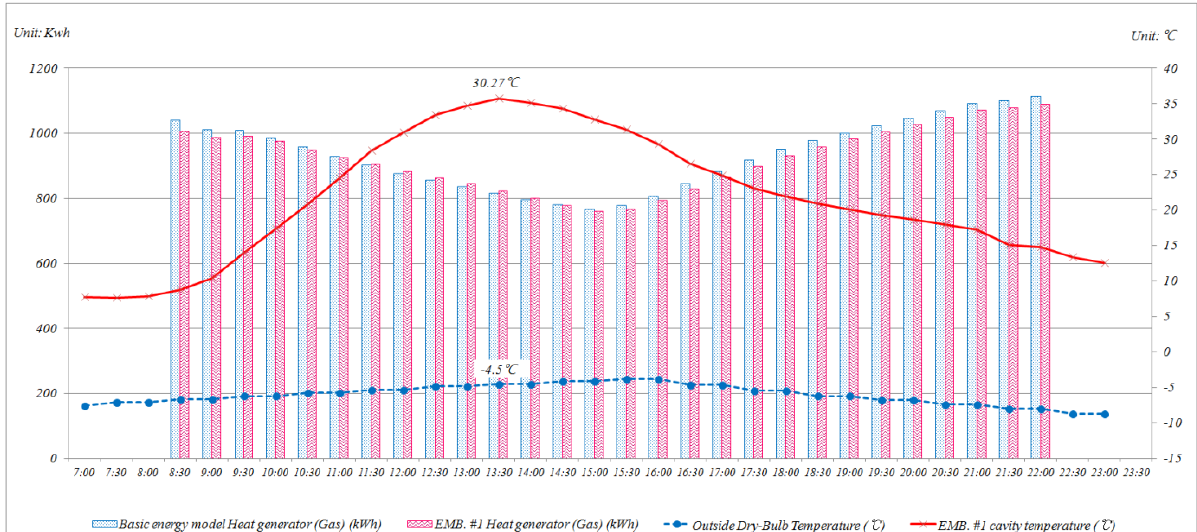
Figure 6. Temperature-time profile and heating energy consumption on a winter day (basic energy model vs. EM B